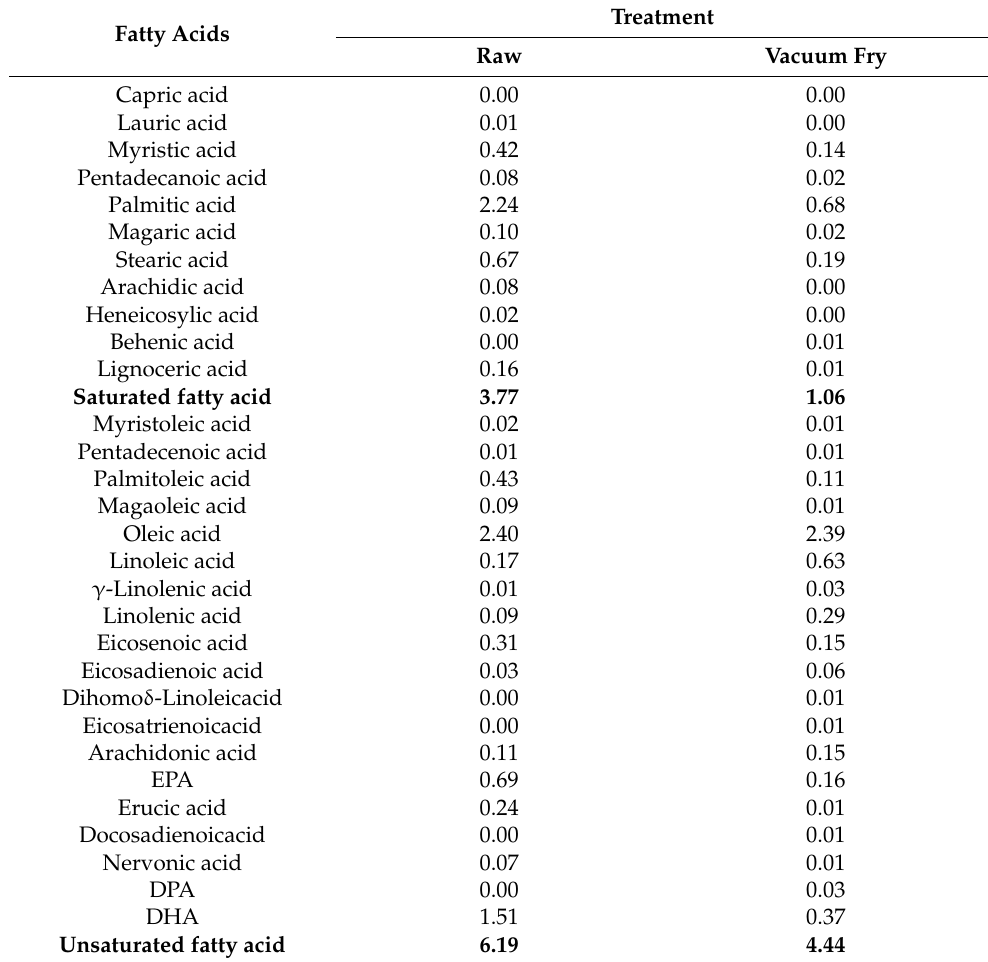
Table 3. Fatty acid profile (g/100 g) of chub mackerel ( Scomber japonicus ) after vacuum